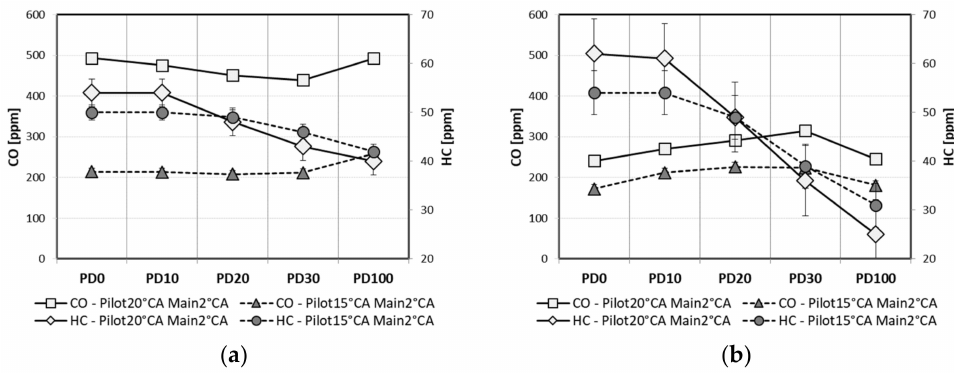
Figure 8. CO and HC by engine load: ( a ) engine load 0 Nm, ( b ) engine load 40 Nm.